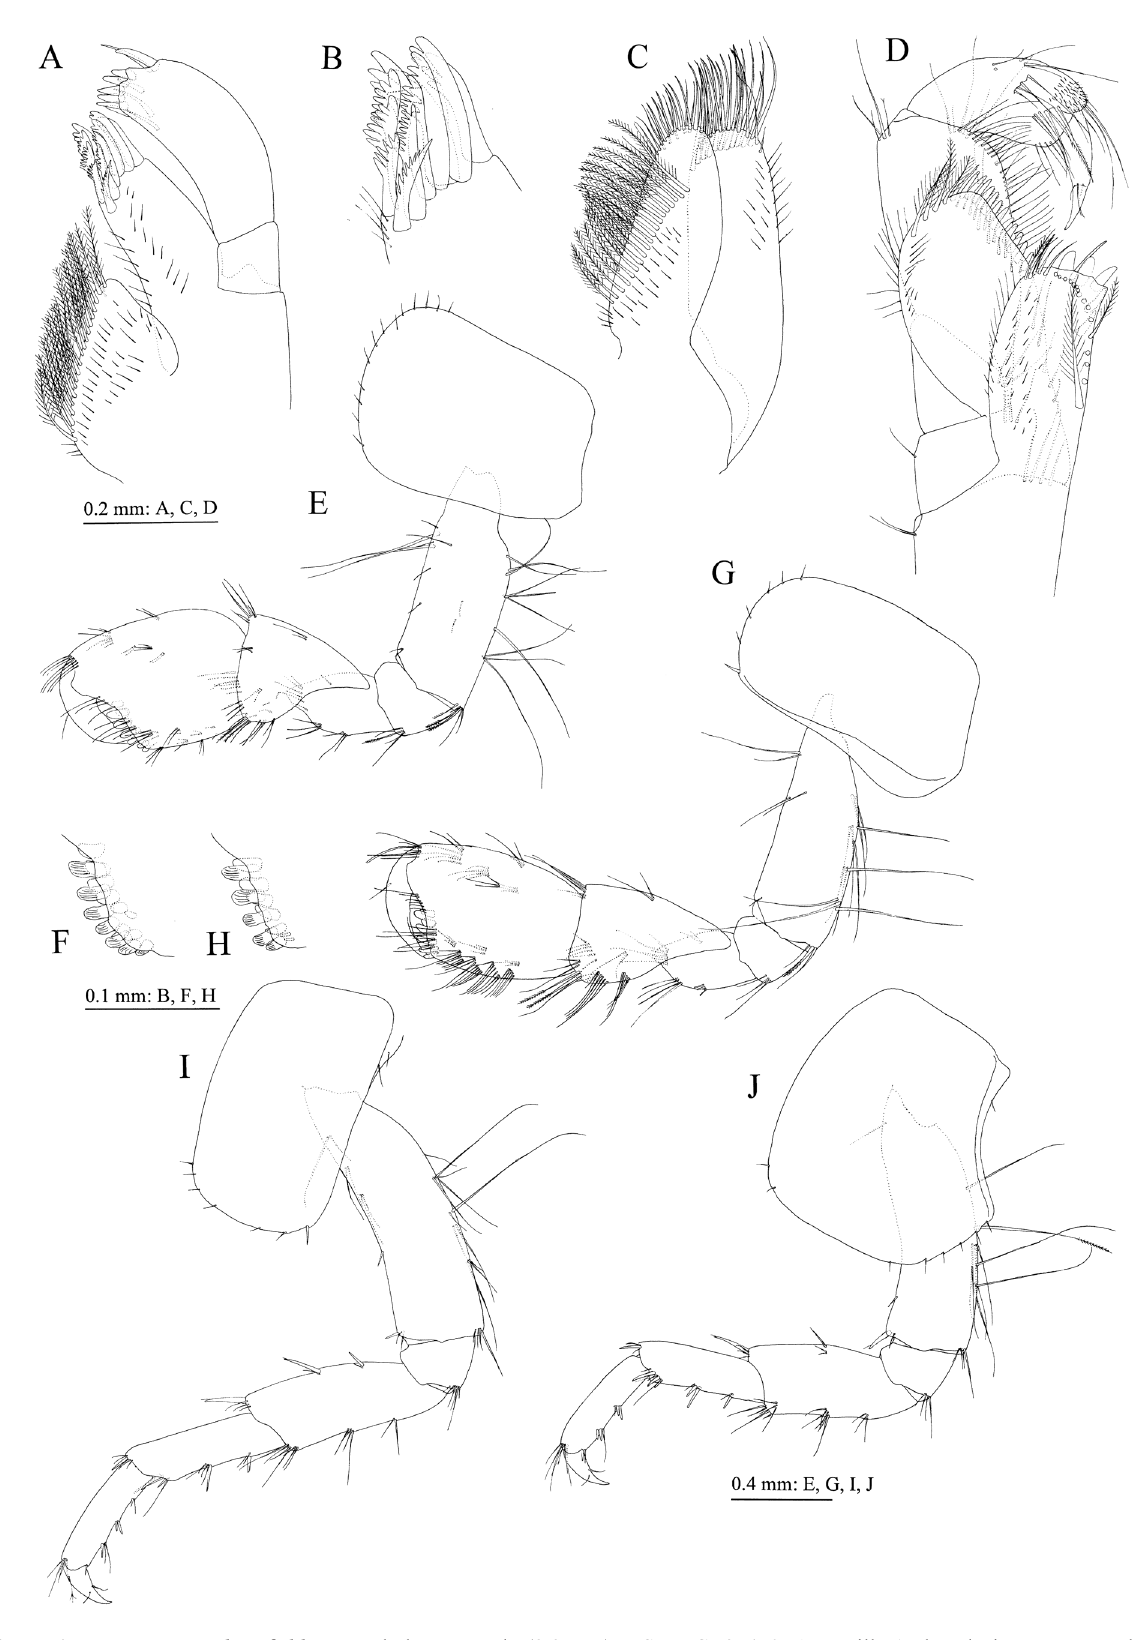
Figure 4. Jesogammarus bousfieldi sp. n., holotype, male (9.8 mm), NSMT-Cr 25470. A maxilla 1, dorsal view; B outer plate of maxilla 1, dorsal view; C maxilla 2, dorsal view; D maxilliped, dorsal view; E gnathopod 1, lateral view; F palmar margin of propodus of gnathopod 1, lateral view; G gnathopod 2, lateral view; H palmar margin of propodus of gnathopod 2, lateral view; I pereopod 3, lateral view; J pereopod 4, lateral